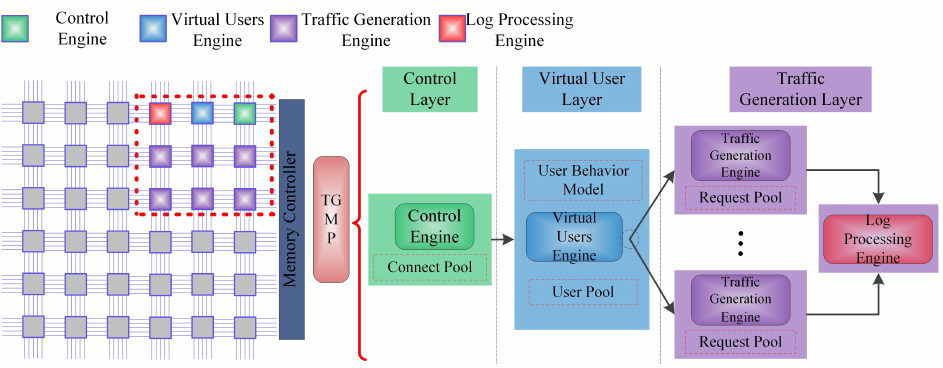
Figure 8. Parallel design on